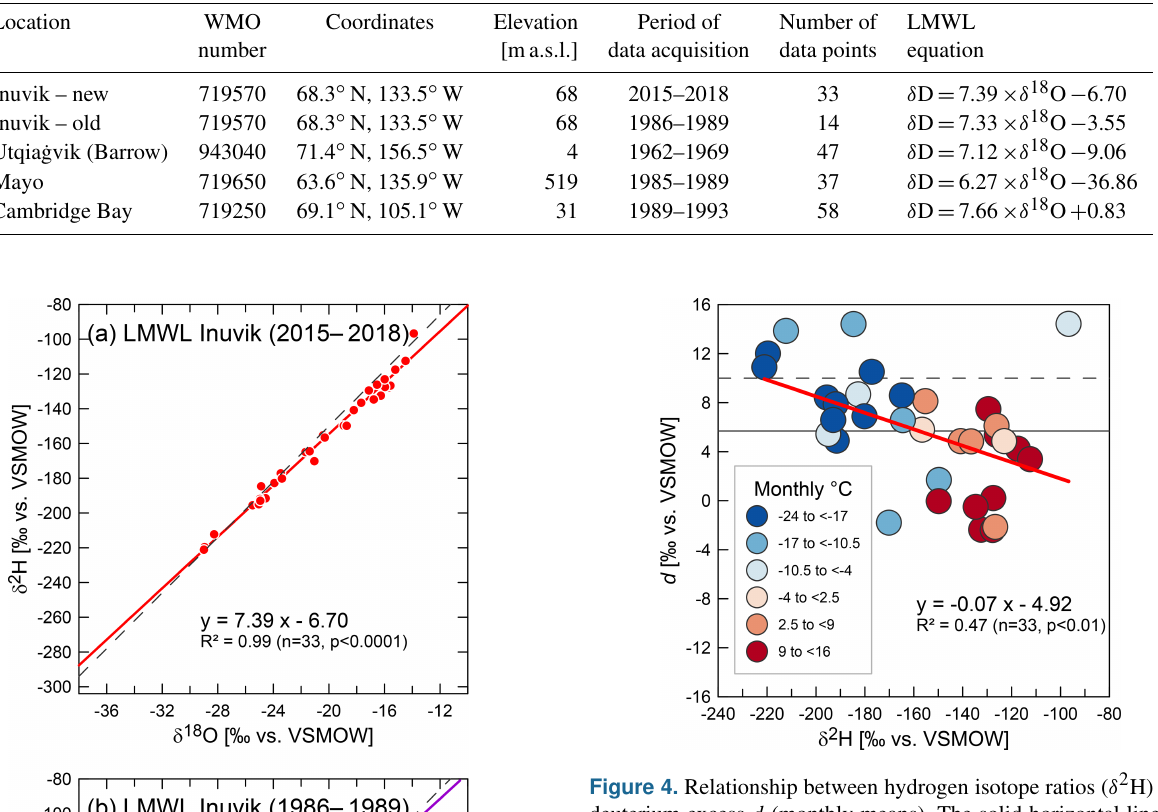
Table 3. Available monthly-based LMWLs from the western Arctic.